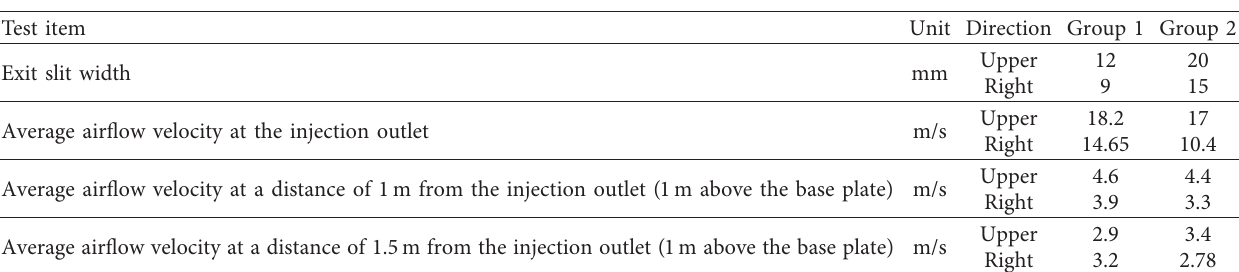
Figure 8: Calculation model of minimum dust removal airflow velocity [23]. u m : maximum average speed in the axial direction, m/s; u 0 : average speed of core area; b : expanded thickness. Table 3: Average test